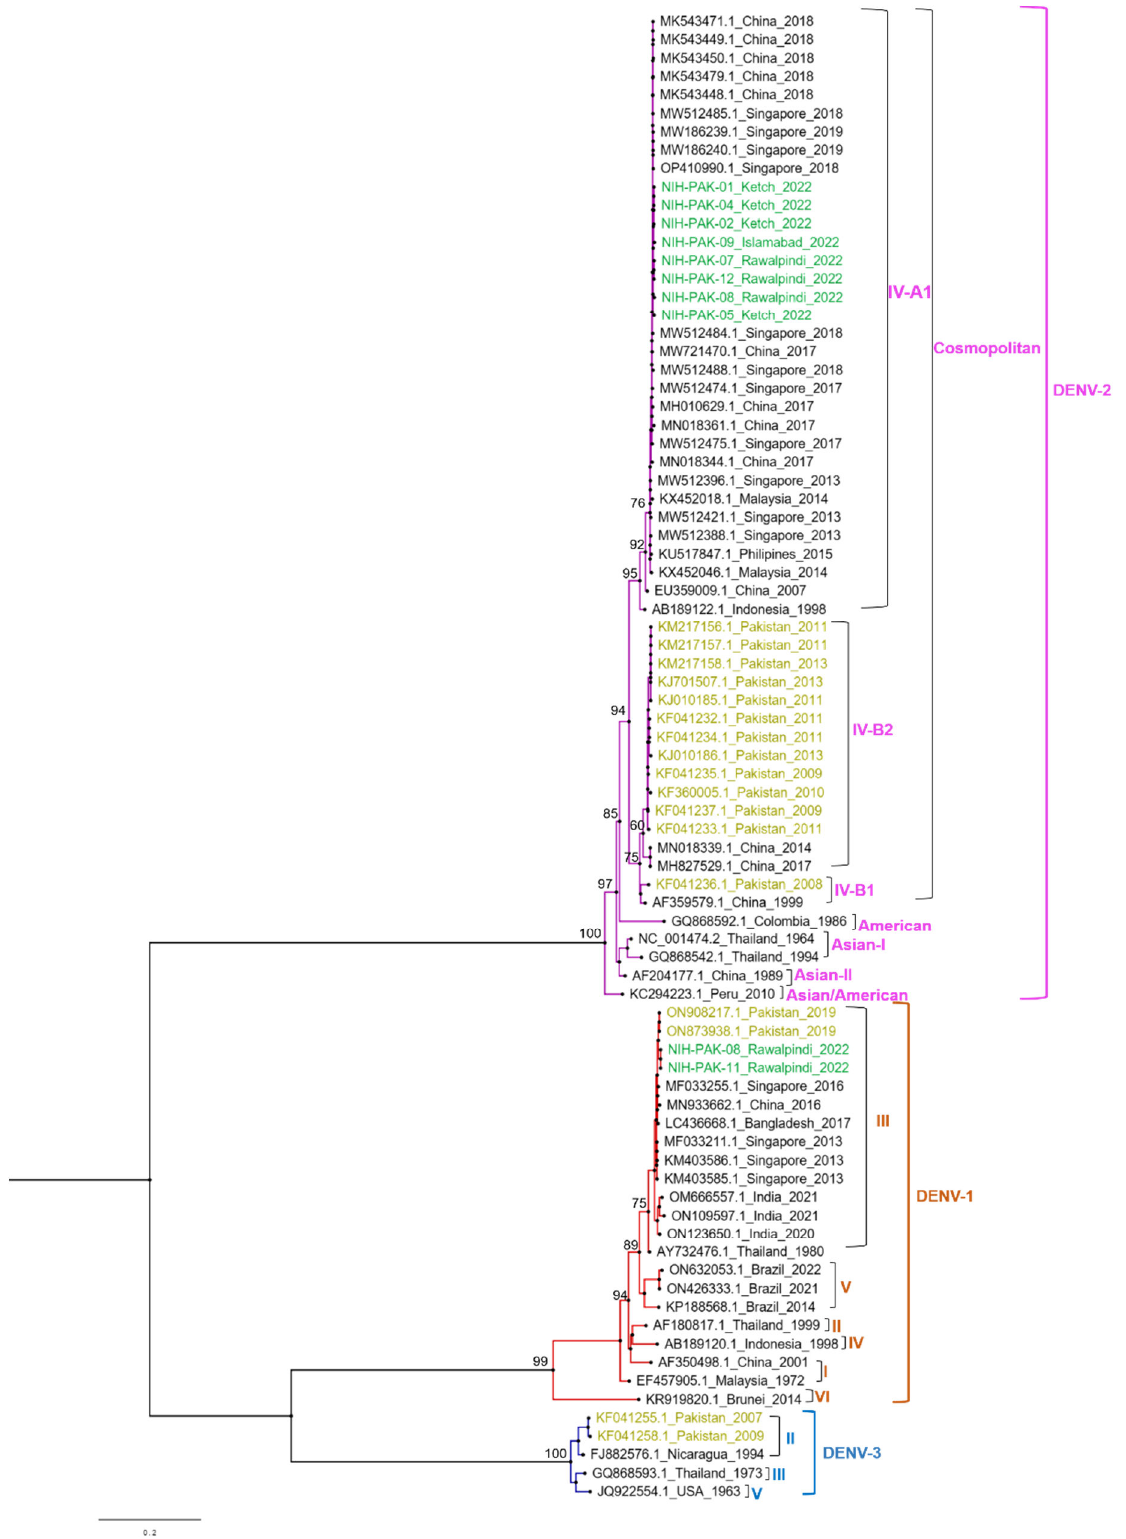
Figure 3. Maximum likelihood phylogenetic tree of dengue full genome sequences. The tree was generated through an IQ tree with 1000 bootstraps. The study isolates are highlighted in green, while the previously reported sequences of DENV from Pakistan are highlighted in yellow.